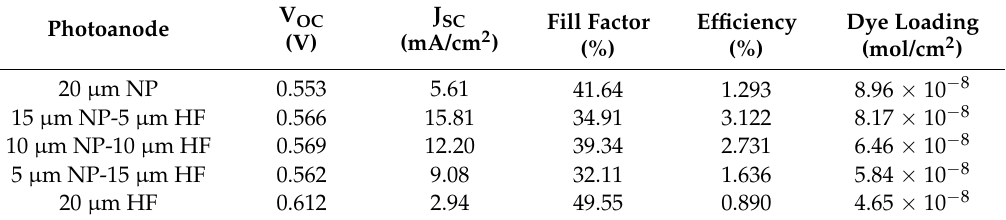
Table 1. Performance parameter of DSSCs with various photoanode layers.